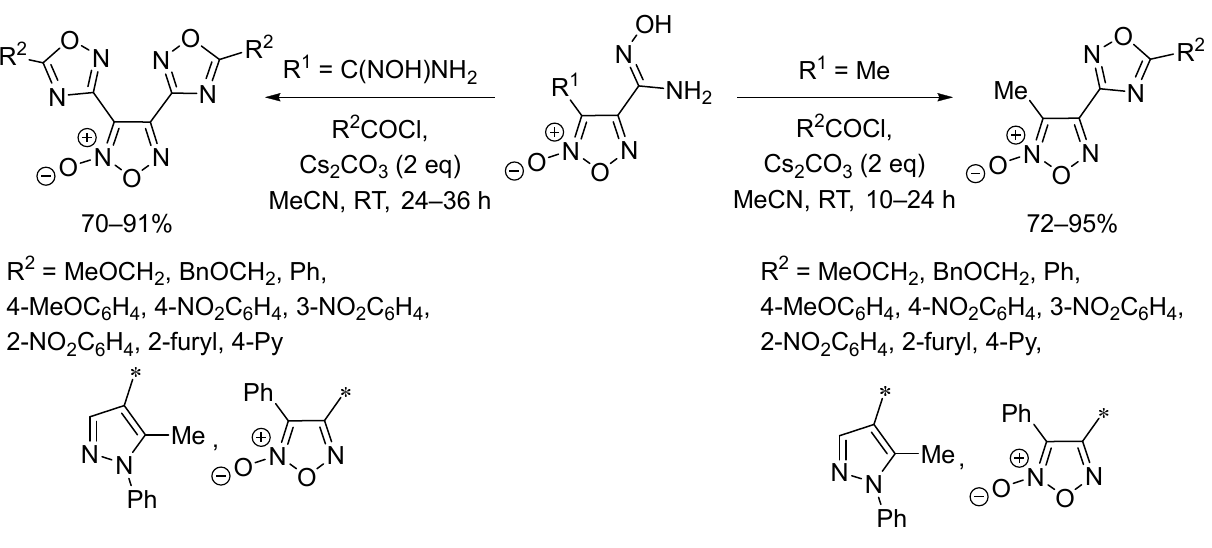
Scheme 9. Preparation of various 1,2,4-oxadiazol-furoxan